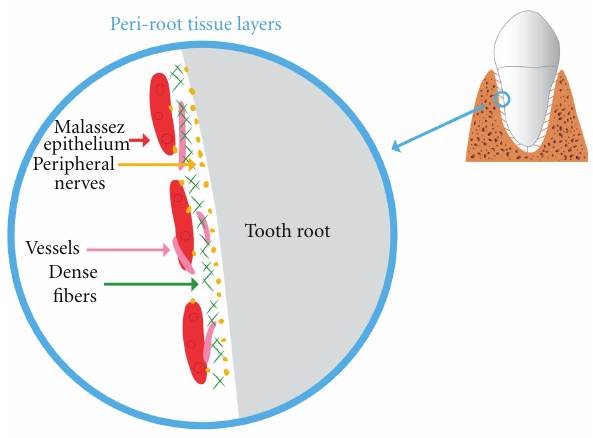
Figure 2: The figure in the circle is an enlargement of the area shown on the tooth in the upper right corner. The cell layers close to the root’s periodontium, also known as the periroot sheet layers, are demonstrated in the circle. Nerve tissue: yellow. Tense fibre layer: green. Malassez epithelial cells: dark red. Vessels: light red. This illustration is reproduced with permission from Orthodontic Waves [27].